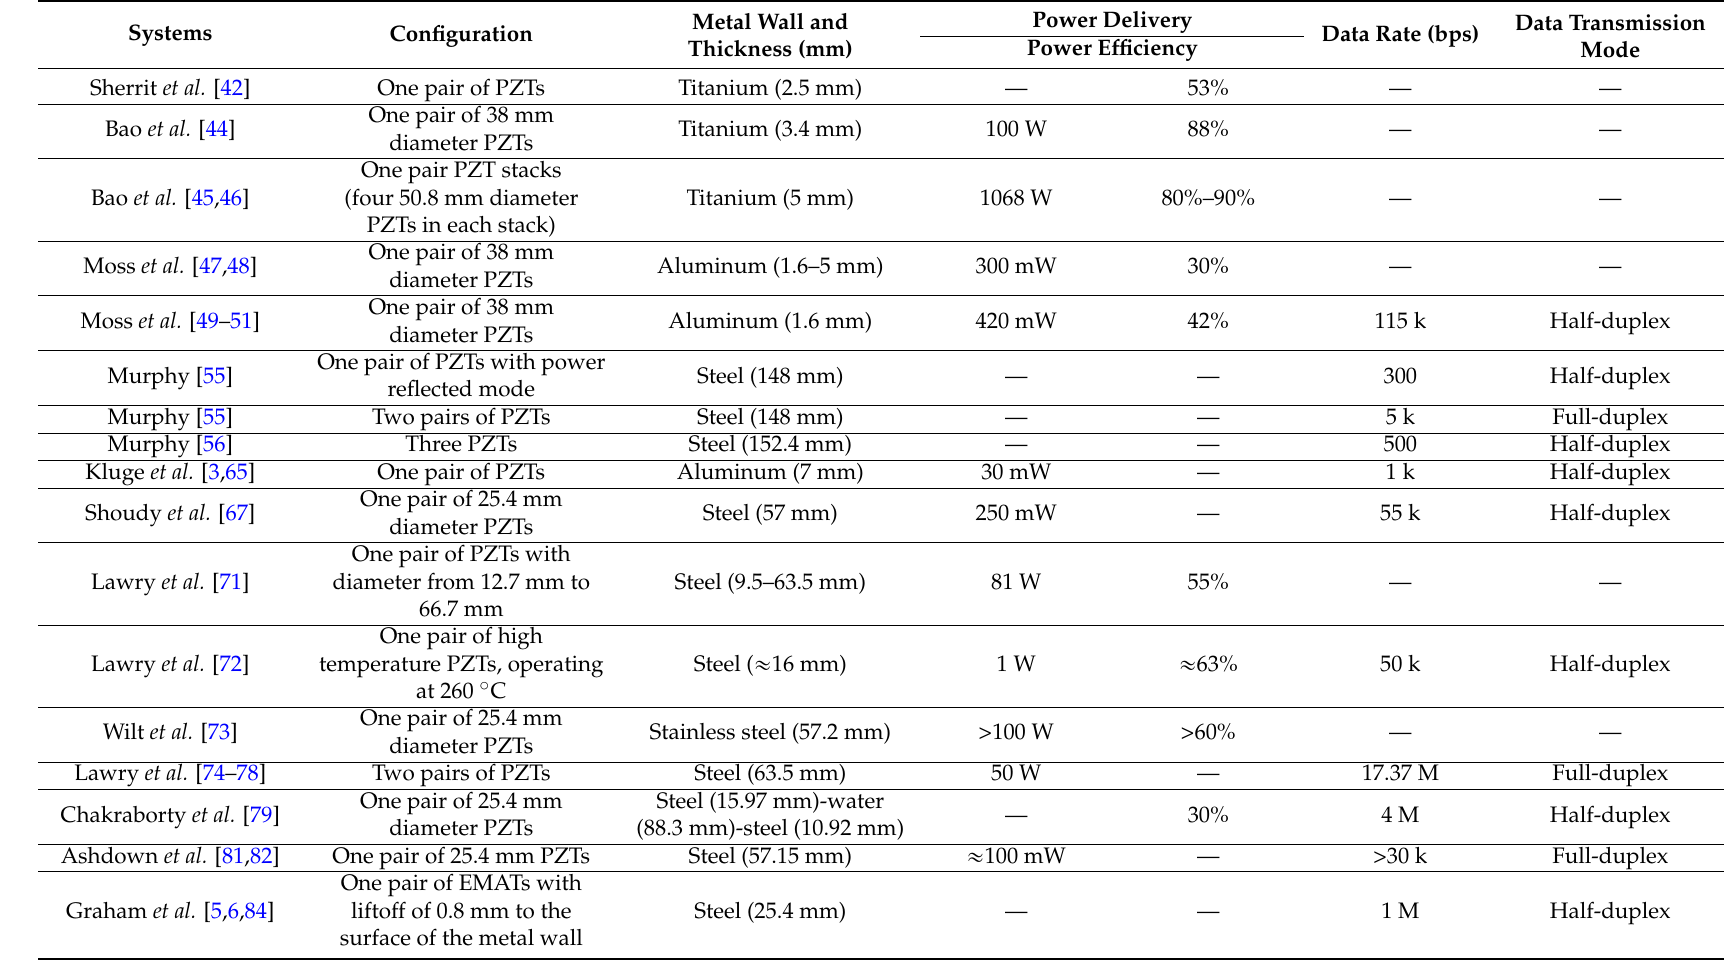
Table 1. Summary of ultrasonic through-metal-wall power delivery and data transmission